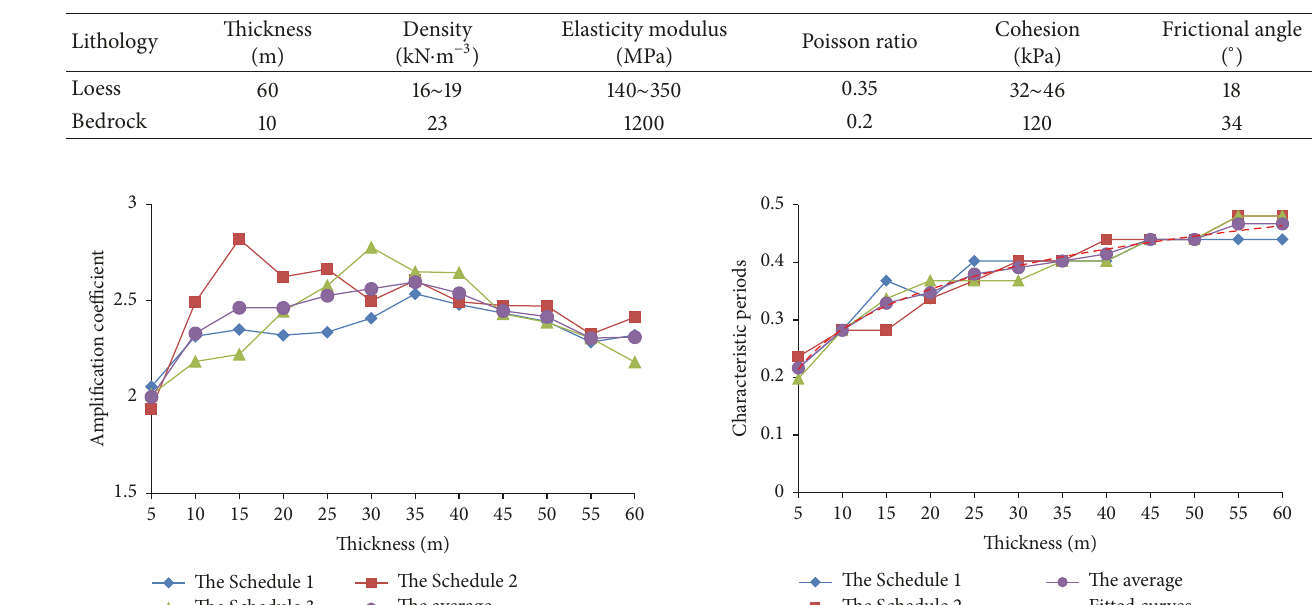
Table 2: Soil mechanics parameters of the finite element model.